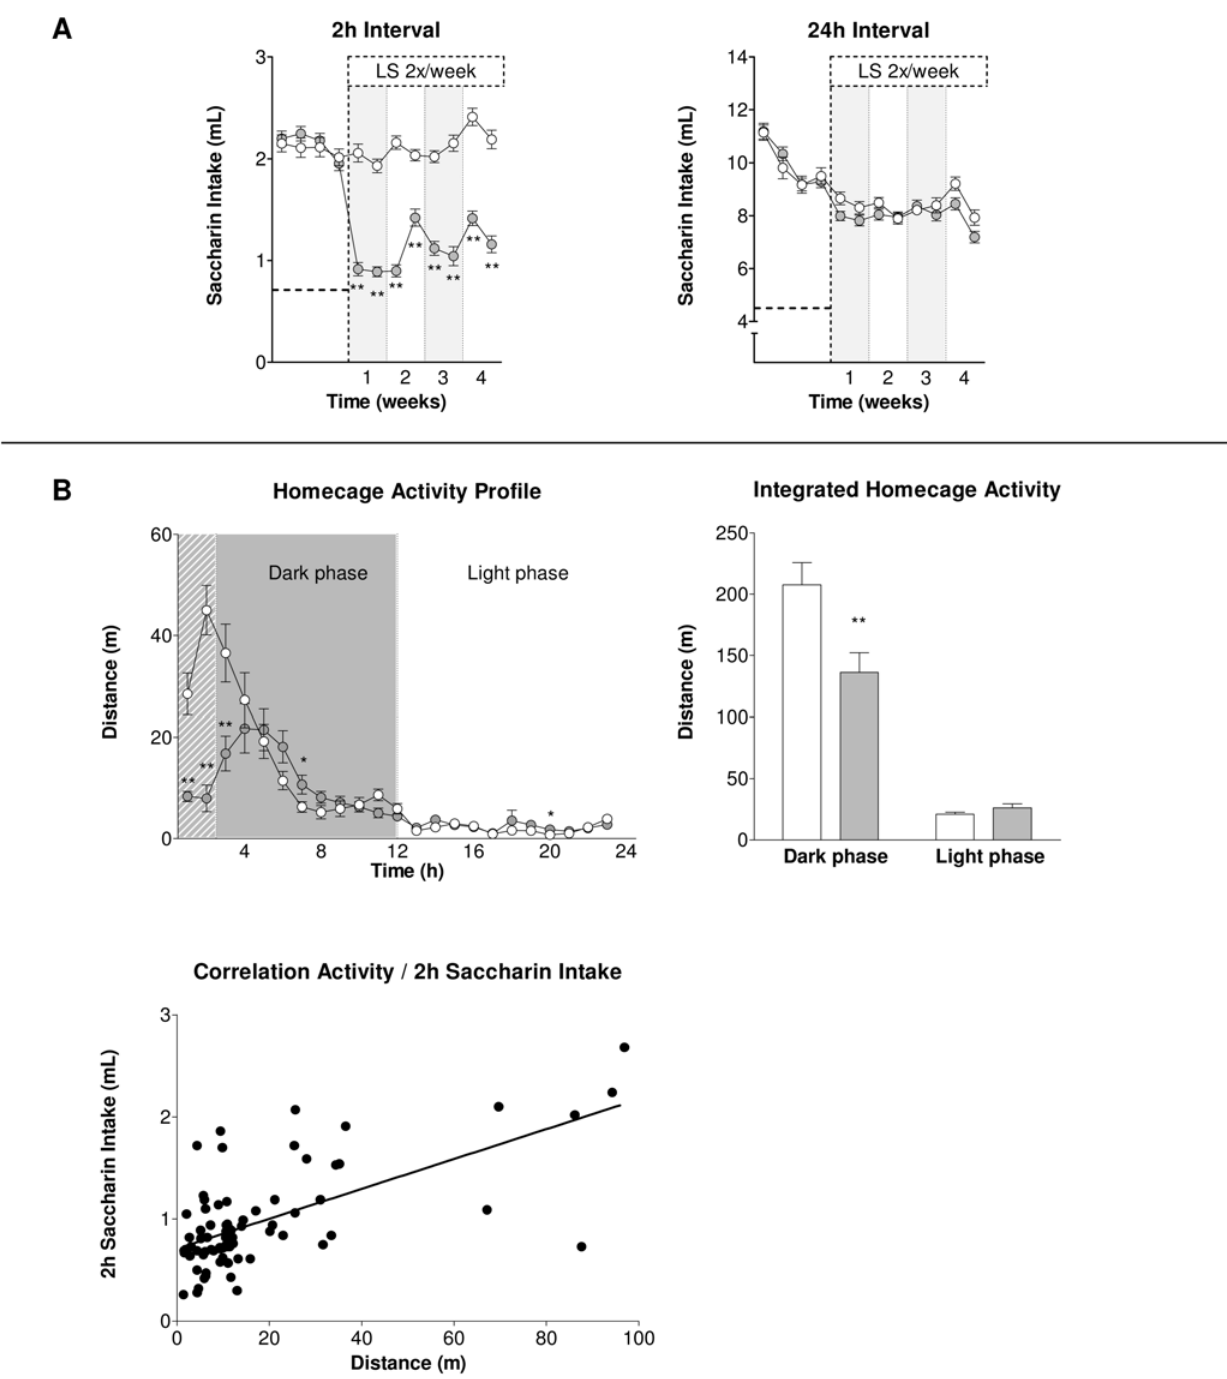
Figure 6. Effects of Light Stress (LS) on subsequent saccharin intake and homecage activity in BL/6J mice. (A) LS resulted in a reduction of saccharin intake during the first 2 hrs interval while there was no effect on overall 24 hrs saccharin intake after LS. The dashed horizontal lines at y=0,72 mL and y=4,80 mL, respectively, represent basal water intake when only water is available in a two-bottle paradigm during the corresponding measurement interval. (B) Profiling of homecage activity for a total of 24 hrs (t 0 =beginning of the dark phase) revealed a distinct decrease during the first hours of the dark phase (which comprised the 2 hrs saccharin measurement interval, hatched area) that was positively correlated with the respective 2 hrs saccharin intake (Pearson’s r=0.64, p , 0.01, n=76, i.e. 40 LS and 36 control animals). Data represent mean 6 SEM, n=36–40/group. White circles and bars: control group, grey circles and bars: light stress group. * p , 0.05, ** p , 0.01 pairwise between-group comparisons (Student’s t-test).